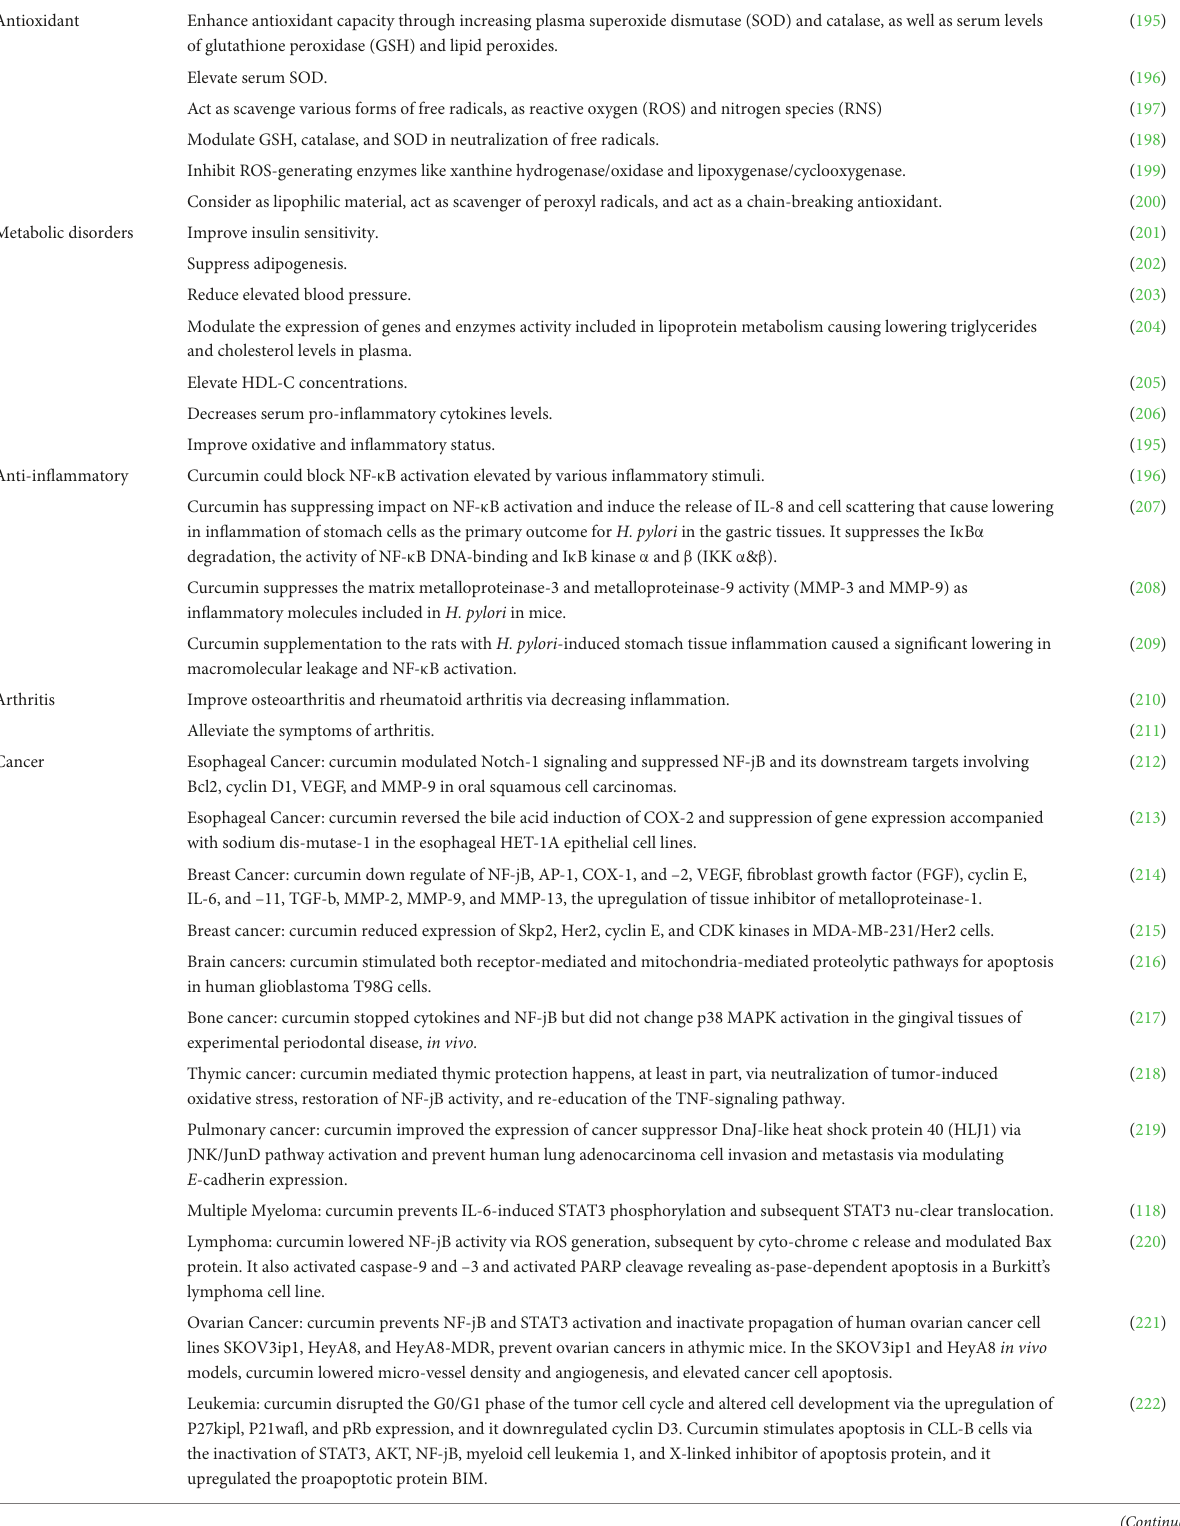
TABLE 4 Therapeutics indications of curcumin, its impacts and mode of